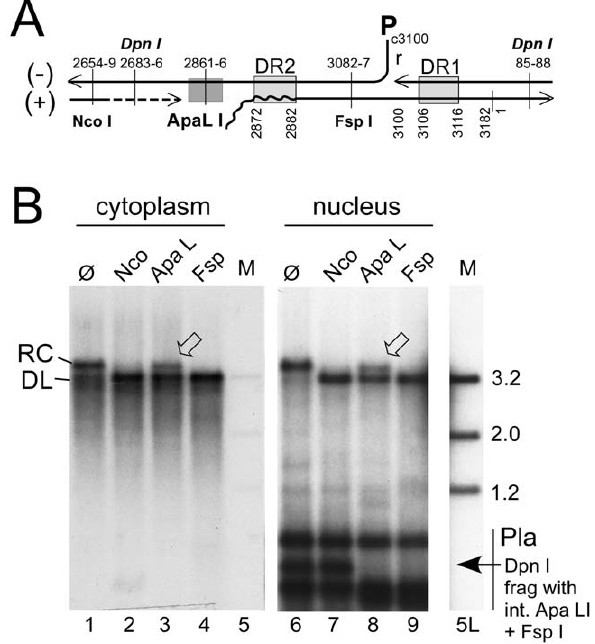
Figure 3. Site-specific discontinuity confirms the rcDNA nature of a substantial fraction of nuclear HBV DNA. Extensive nicking of HBV cccDNA might pretend an artifactually high ratio of rcDNA to cccDNA in the nucleus. However, nicking should occur at random whereas RC-DNA is distinctly discontinuous where the minus-strand and plus-strand DNA start. ( A ) Scheme of HBV rcDNA discontinuities. Restriction site positions are indicated with the first and last nucleotide of the recognition sequences. The Apa LI site is located immediately upstream of the plus-strand start. DNA in which the plus-strand is not sufficiently extended can not be cut. DR1 and DR2, direct repeats 1 and 2; wavy line at DR2, RNA primer at plus-strand 5 9 end. ( B ) About one third of the rcDNA signal is resistant to Apa LI but not Nco I or Fsp I digestion. Cytoplasmic (treated with MN) and nuclear (treated with Dpn I) DNA preparations (both after prior PK digestion) were incubated with the indicated restriction enzymes. Consistently (Figure S5B), , 35% of the rcDNA signal from the cytoplasm as well as the nucleus remained upon incubation with Apa LI (arrowheads) but not Nco I or Fsp I. Activity of Apa LI in the reactions is documented by the absence of a plasmid-derived Dpn I fragment containing internal sites for Apa LI and Fsp I but not Nco I. All samples were run on the same gel but a six-times longer exposure is shown for the nuclear samples; lane 5L on the longer exposure corresponds to lane 5 on the left panel. M, marker fragments of the indicated sizes (in kb).